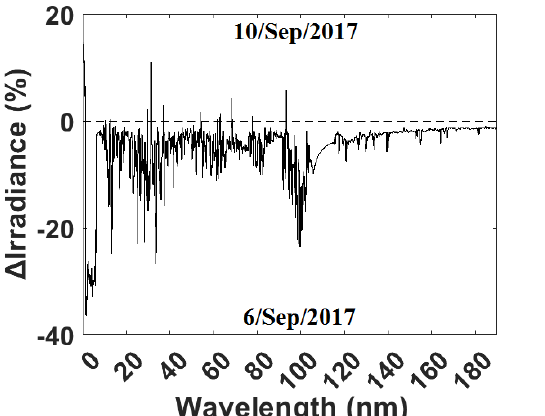
Figure 2. Relative difference in radiation percentage of the outbreak on 10 September 2017 to 6 September